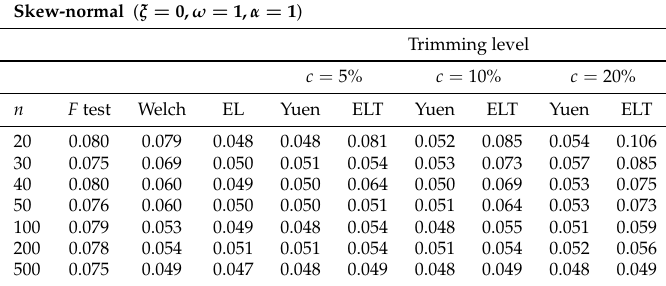
Table 3. Empirical probability of type I error for various tests for the equality of means and trimmed means of three independent skewed distributions with the ratios between variances being